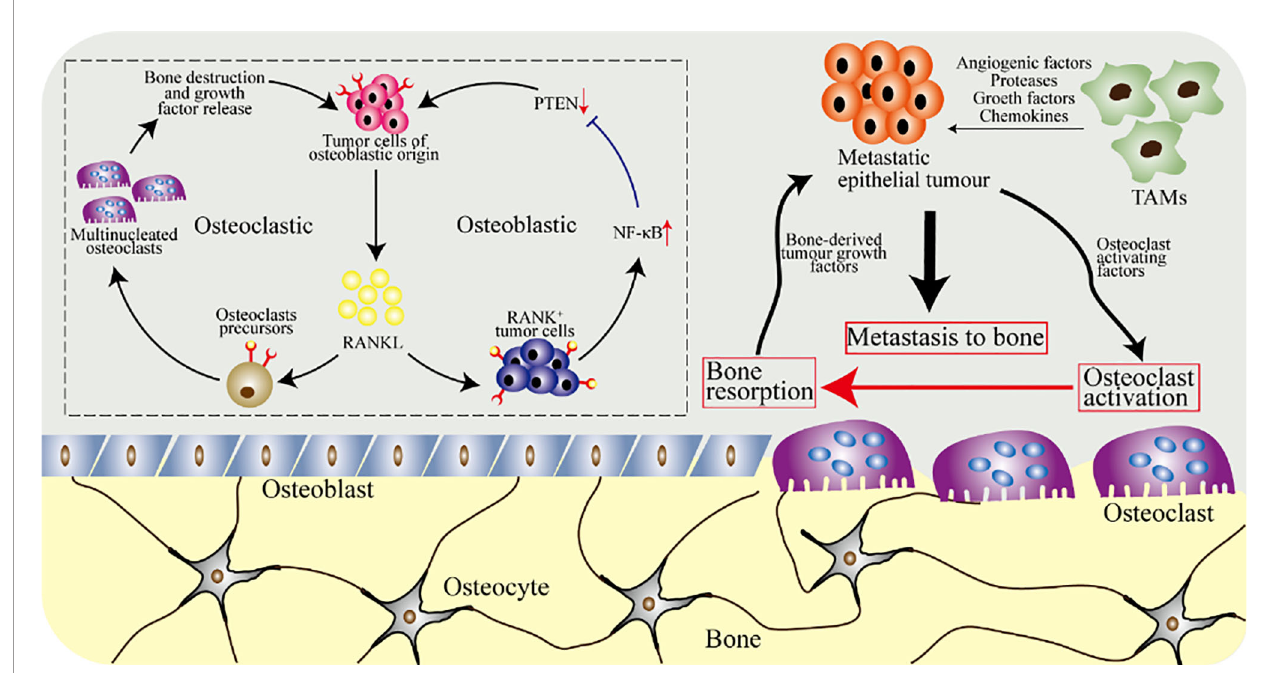
FIGURE 6 | The osteoclasts and macrophages in osteosarcoma. Tumor cells of epithelial origin, such as breast tumor cells, have a tendency to metastasize to bone. Tumor-associated macrophages (TAMs) secrete growth factors and angiogenic factors, and stimulate epithelial tumor cells to secrete proteases and chemokines required for metastasis. Metastatic tumor cells further release cytokines, breaking the balance of osteoclasts and osteoblasts, increasing the activation of osteoclasts and accelerating bone resorption. Furthermore, osteoclasts release cytokines in the bone matrix to further promote the growth of metastatic epithelial tumor cells. The upper left picture shows the cellular and molecular biological effects of local osteosarcoma progression caused by tumor cells and RANKL, which are mediated by osteoblasts and